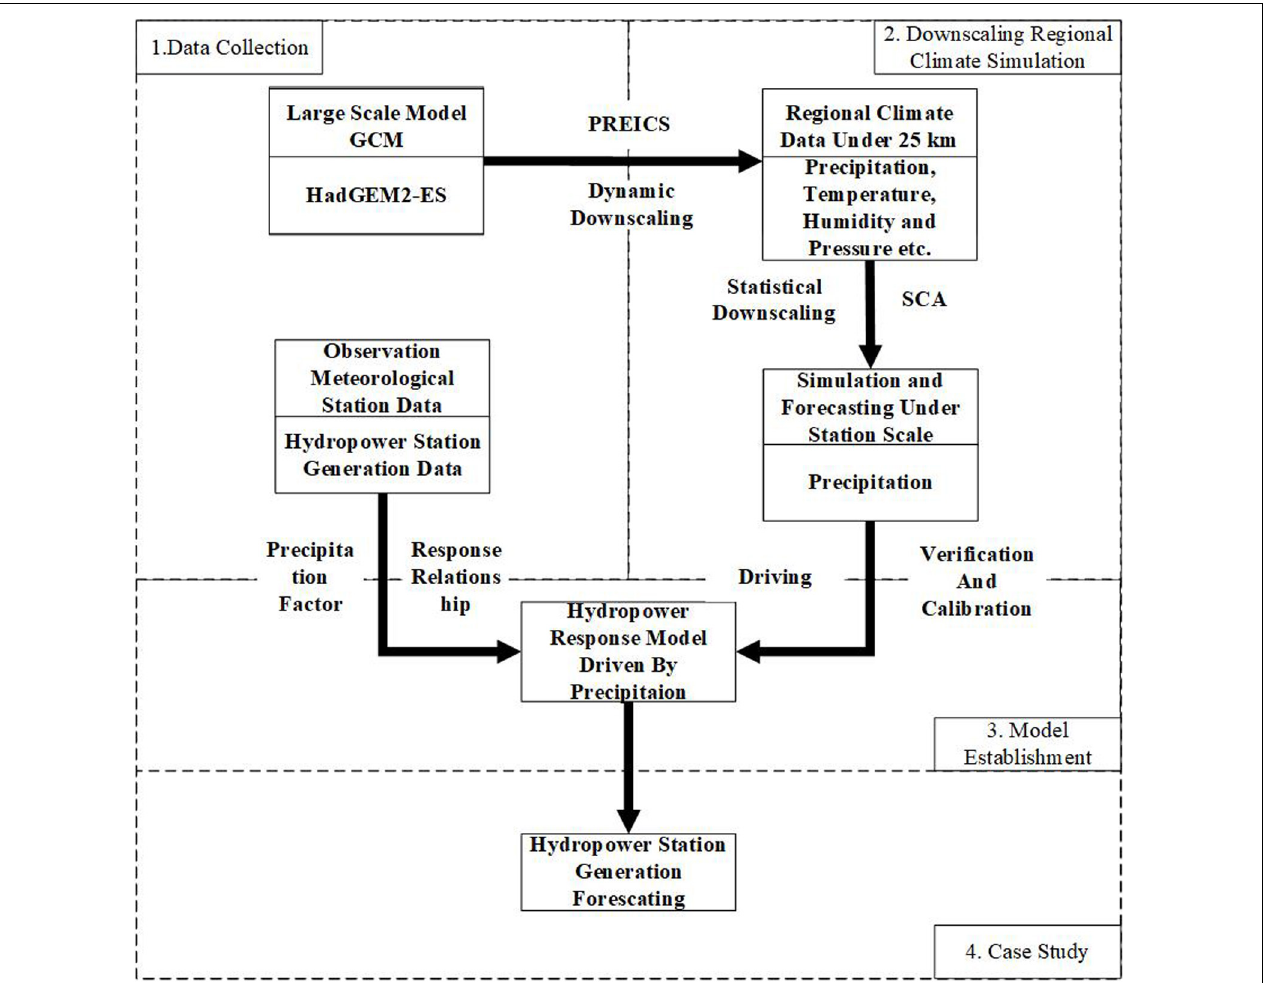
FIGURE 1 | Study flow chart.